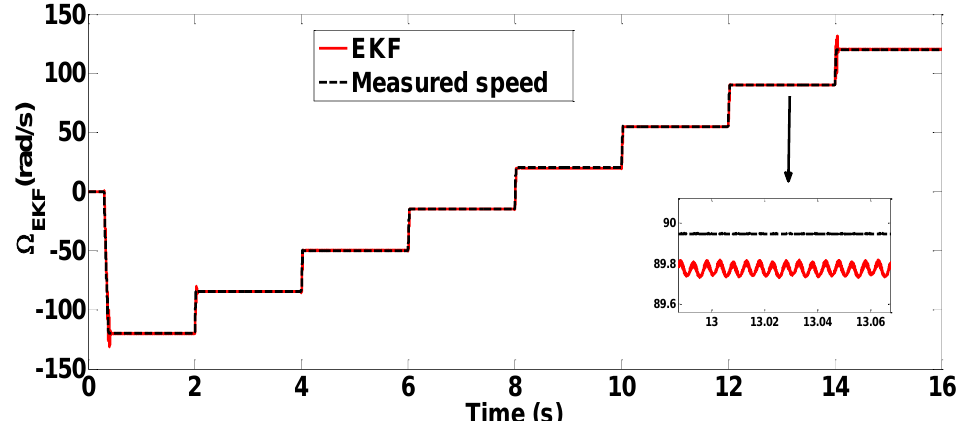
Figure 6. Estimated velocity response using of EKF at medium- and high-velocity operation ranges.